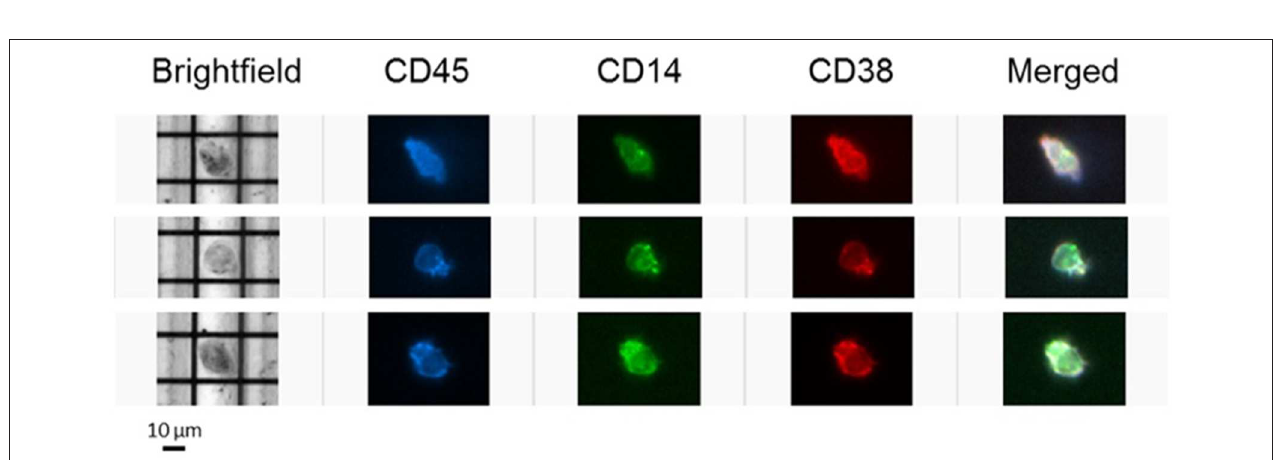
FIGURE 4 | CD38-expressing tumor-infiltrating leukocytes were visualized using the DEPArray TM platform. Three single cells resembling macrophages are presented. Cells are large ( > 10 µ m), irregularly shaped and express myeloid marker CD14.